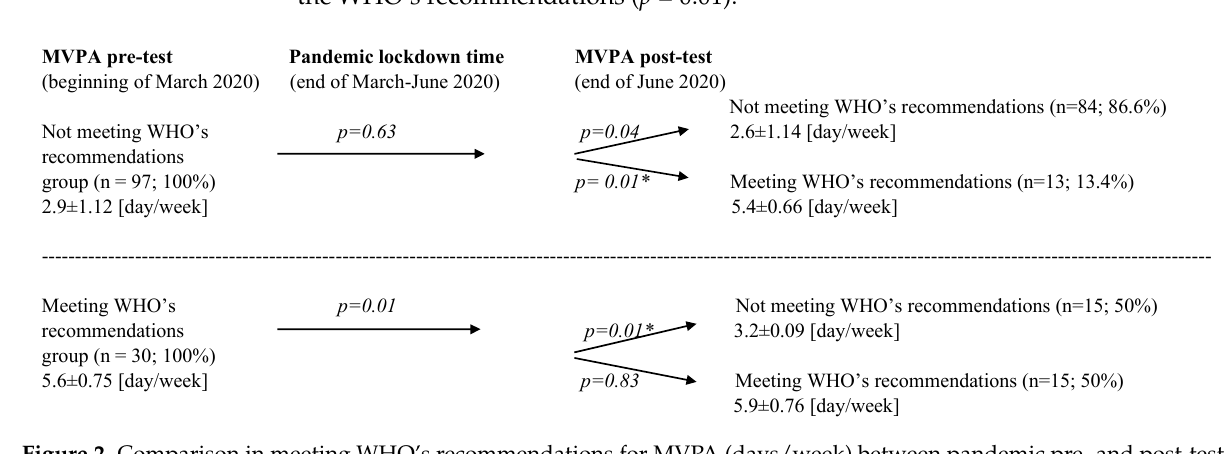
Table 1. Correlation among study